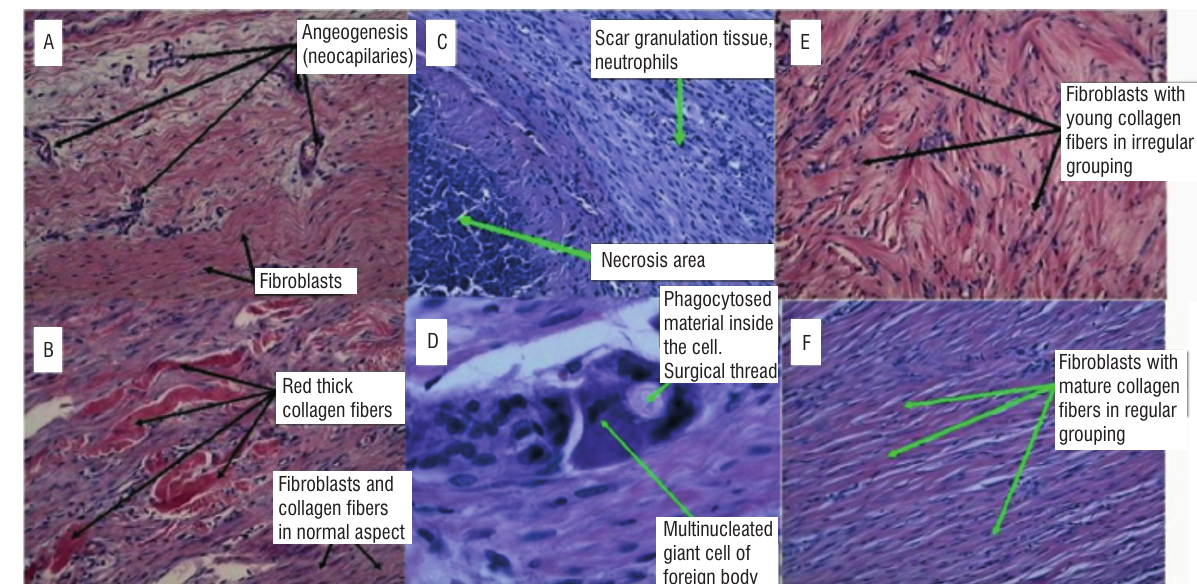
Figure 4 - A) The results of the Tsai technique (6-strands), displaying granulated tissue and angiogenesis on the 15 th day (100x). B) Histological section of suture with Tsai technique (6-strands) – 15th postoperative day. Granulation tissue with deposit of thick collagen fibers (100x increase). C) The results of the Brazil technique (4-strands) on the 30 th day, showing an area of necrosis in the periphery of the tendon without damage to the healing (100x). D) The results of the Indiana technique (4-strands) on the 15 th day, showing a multinucleated giant cell from a foreign body (400x). E) The results of the Tsai technique (6-strands) on the 15 th day, depicting the beginning of healing, immature collagen fibres (100x). F) The results of the Tsai technique (6-strands) on the 30 th day, revealing the posi- tion of mature collagen fibres in the same direction of the axis of the tendon. Optimal healing